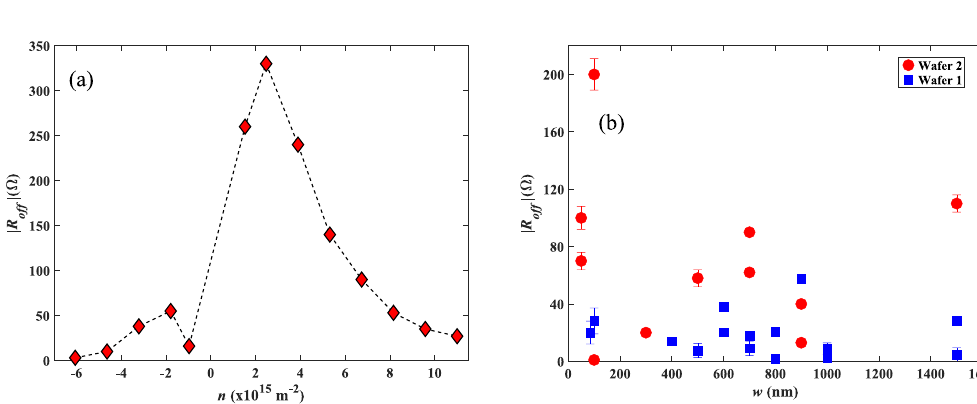
Figure 8. ( a ) Hall offset as a function of n for a 700 nm cross. The dashed line is a guide to the eye. ( b ) Hall offset as a function of device size at similar values of R H in the range 140–180Ω/T and fixed drive currents of 10 µ A for two different graphene